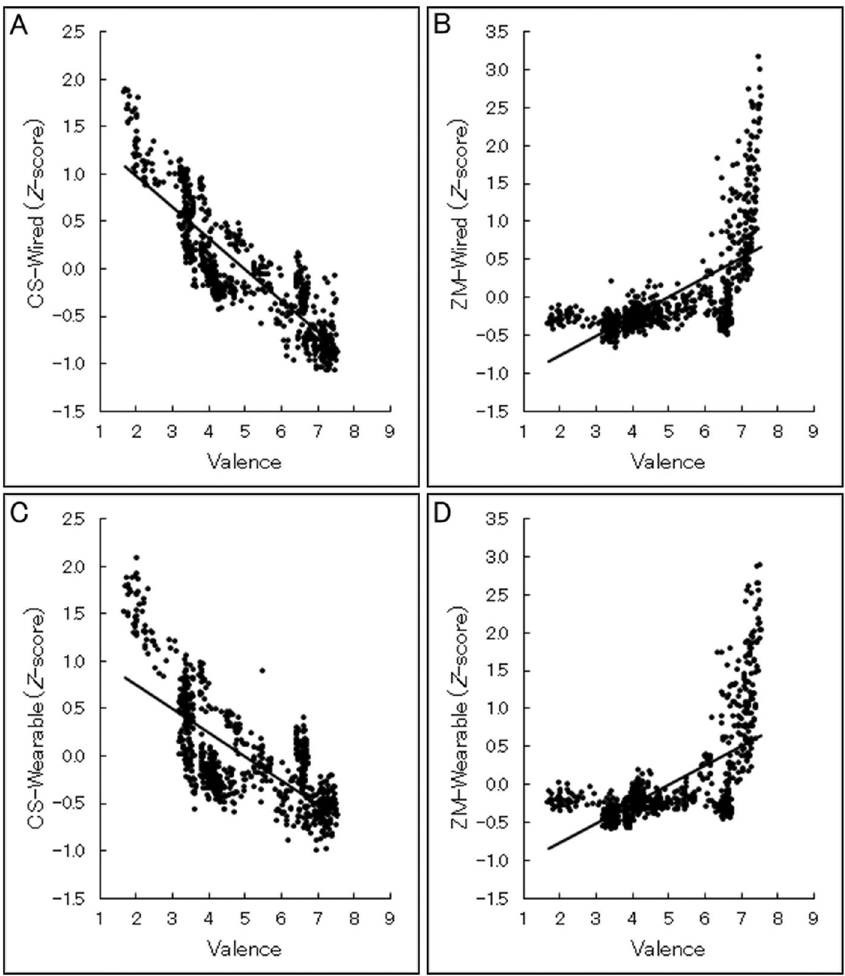
Figure 5. Group-averaged scatterplots and regression lines of relationships between continuous subjective valence ratings and facial electromyography (EMG) signals in Experiment 1. The facial EMG data were recorded from the corrugator supercilii (CS) and zygomatic major (ZM) muscles using the wired ( A , B ) and wearable ( C , D ) devices. The facial EMG data were standardized within individuals.